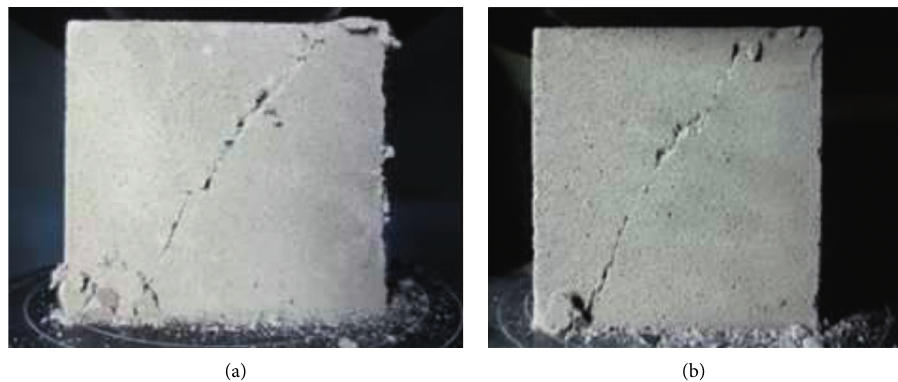
Figure 17: The failure mode of the specimen (compression test). (a) Blended with fiber. (b) Without adding fiber.